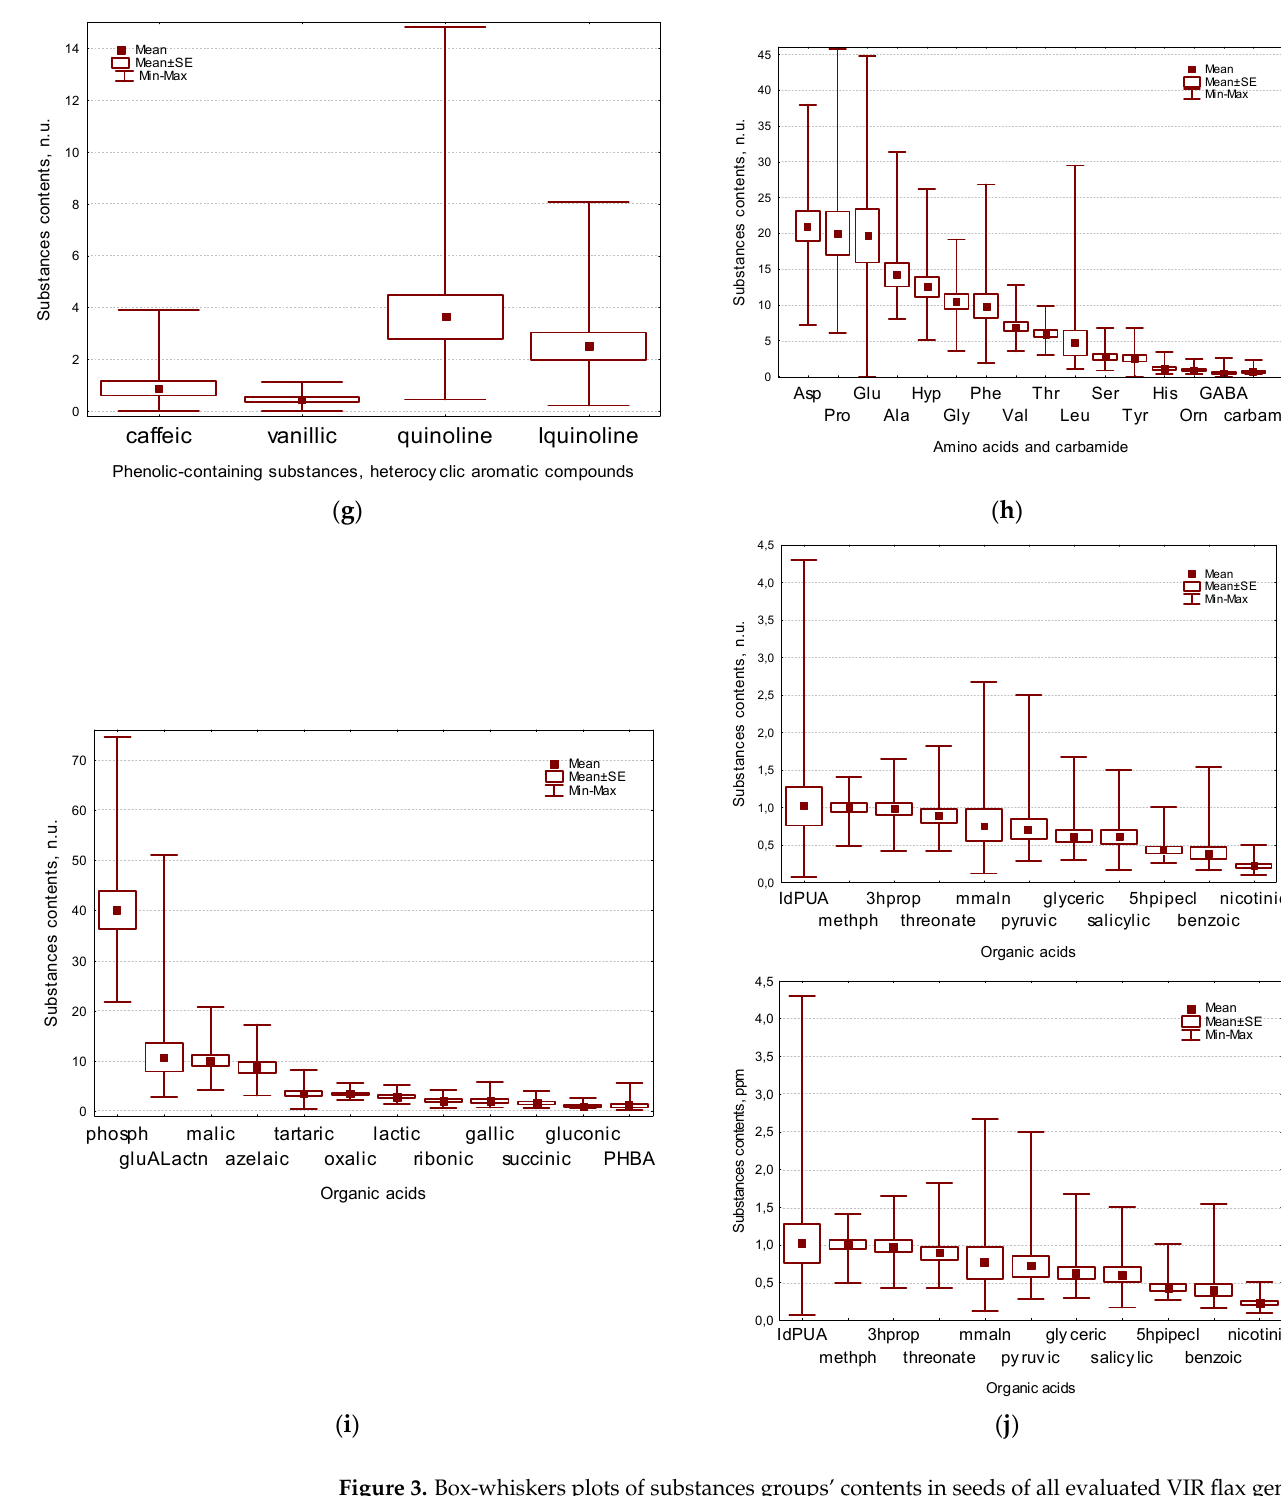
Figure 3. Box-whiskers plots of substances groups’ contents in seeds of all evaluated VIR flax genetic collection lines) (in n.u.). ( a , b )–sugars; ( c , d )–fatty acids, glycerols, paraffin; ( e )–polyatomic alcohols, ( f , g )–phytosterols, phenol-containing substances, heterocyclic aromatic substances; ( h )–amino acids and carbamide; ( i , j )–organic acids. Middle point is mean, Box is mean ± standard error, whiskers are min-max interval. Abbreviations see in Table 1. Significantly more sugars in comparison with other lines, are formed by the black seeds line gc-432 ( Xyl, Ara, Rib, Fruct, Sorb, Gal, Glc, Suc, Raf, Tur, 2OgliDgal ), as well as gc-119 ( Lyx, methGluD, Malt, Raf, Tur ), gc-141 ( Glc, Melib ), gc-121 ( Melib, Malt ), gc-